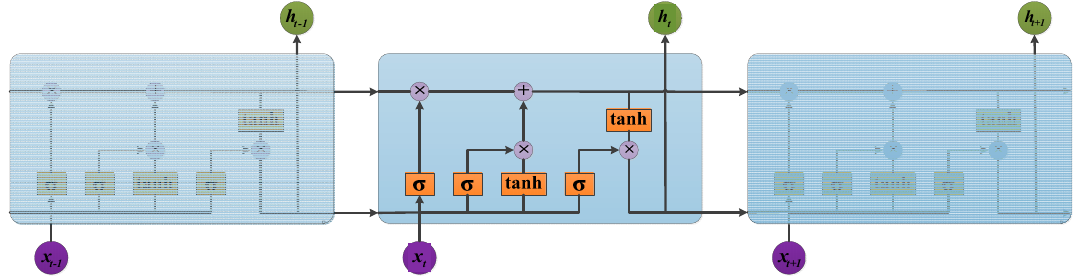
Figure 2. Long short-term memory (LSTM) memory cell structure.